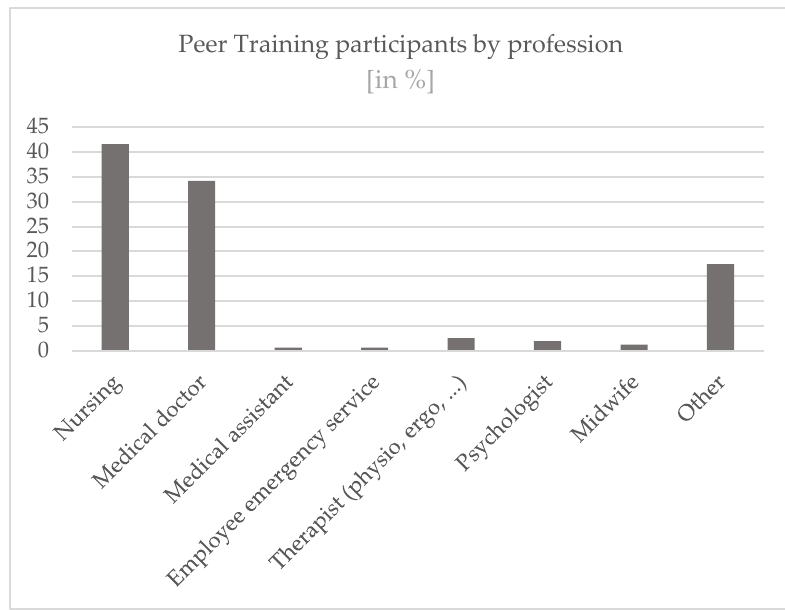
Figure 1. Profession details.